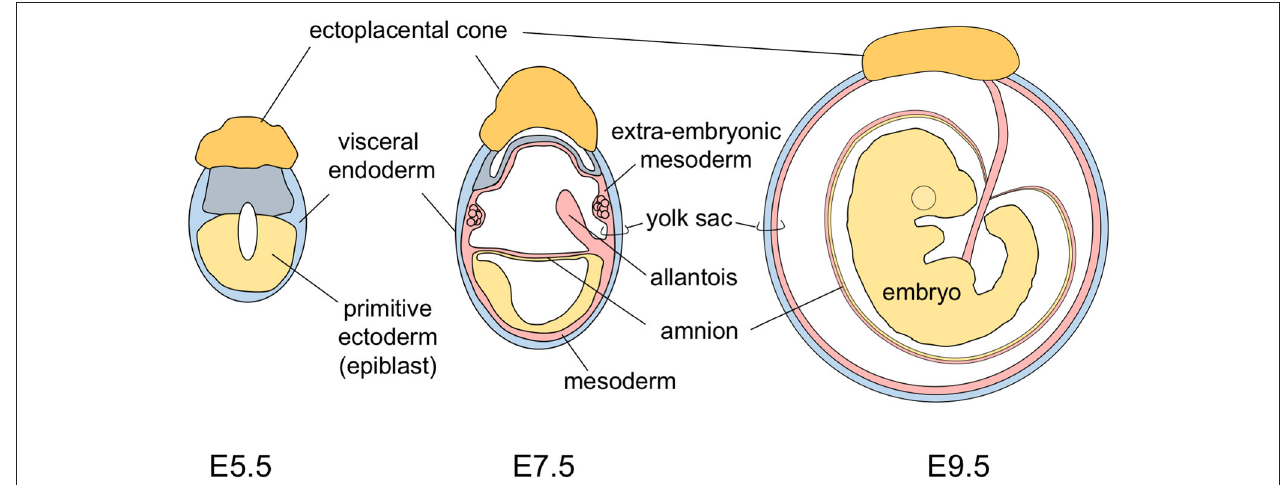
FIGURE 1 | A schematic representation of mouse development from stages E5.5 to